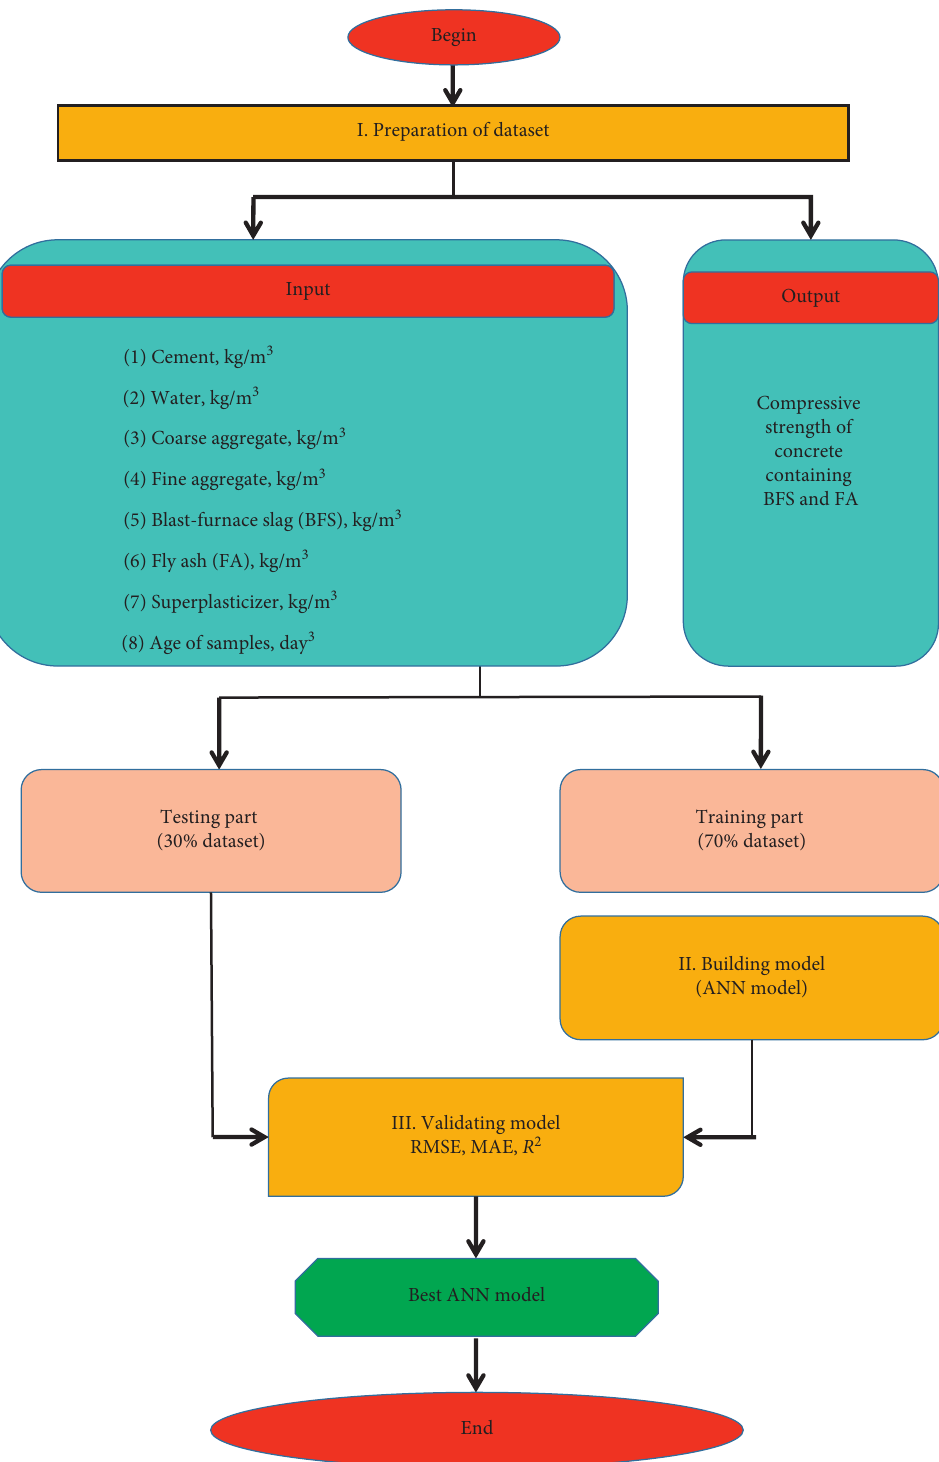
Figure 4: Methodology flow chart of this